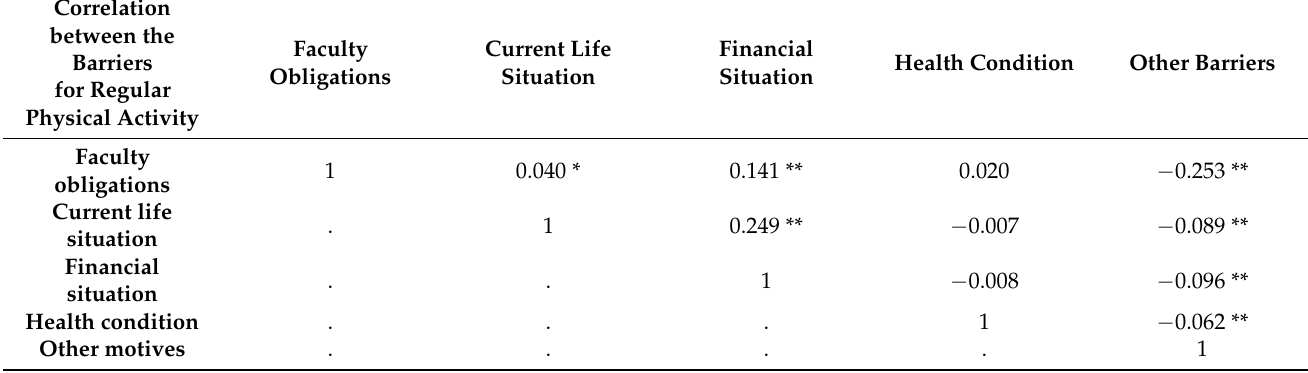
Table 10. Correlation between the barriers for regular physical activity among medical